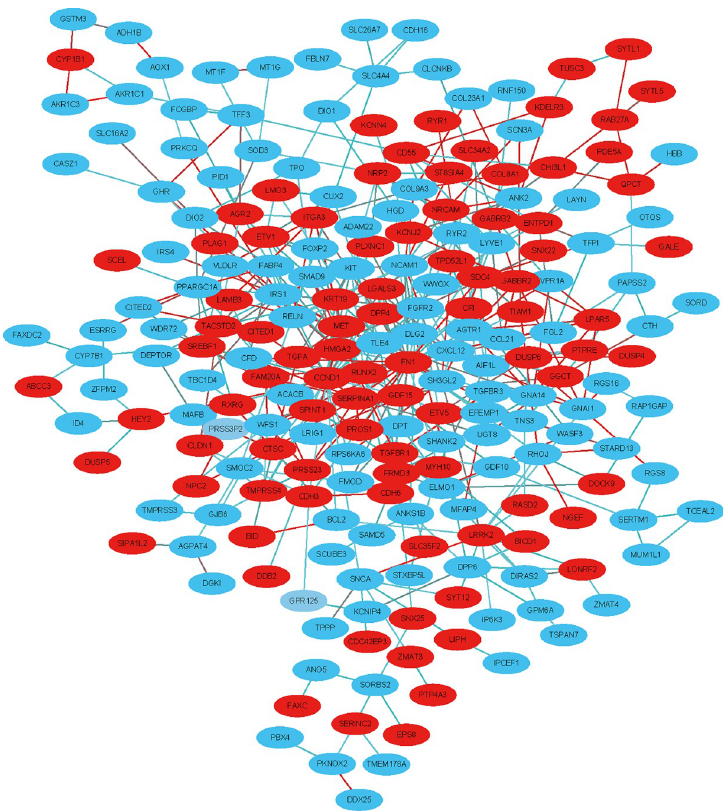
Fig 3. PPI network construction using STRING and Cytoscape. Each node indicates a protein module; the edges represent protein interactions; red circles denote upregulated DEGs and blue circles represent downregulated DEGs.